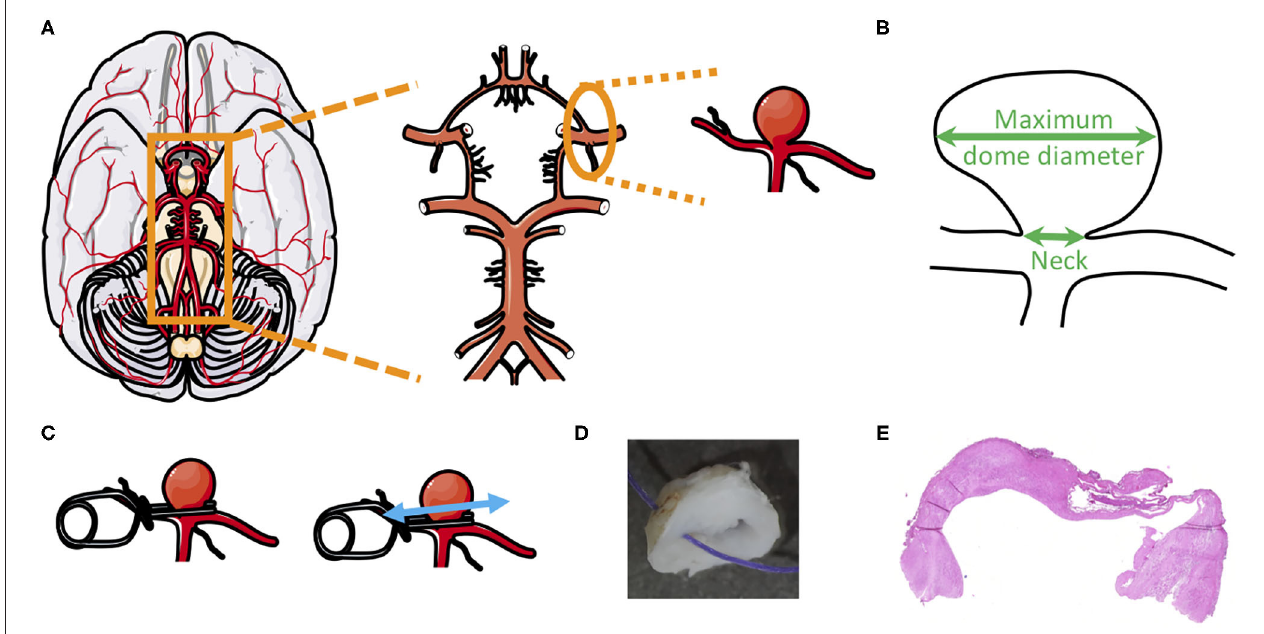
FIGURE 1 | Intracranial aneurysm dome, from the circle of Willis to histology. (A) Example of intracranial aneurysm location in the circle of Willis. (B) Schematic representation of an aneurysm dome to show where neck size and maximum dome diameter were measured. (C–E) After clipping of the IA neck (C) , the IA dome was resected and fixed in formol (D) , cutted and stained with hematoxylin and eosin (E) to allow IA wall thickness